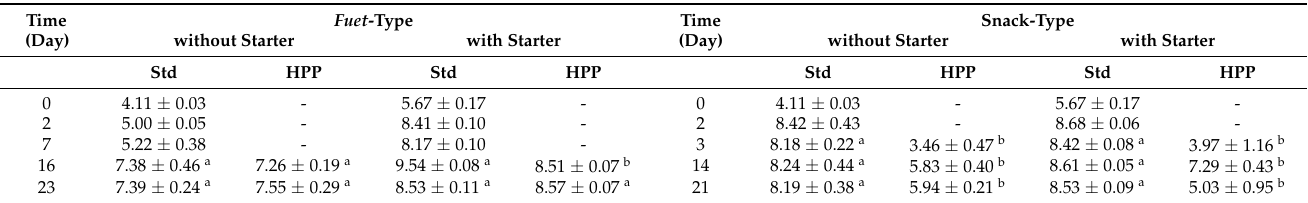
Table 2. Counts (Log 10 cfu/g) of lactic acid bacteria during the production and after storage of fuet -type (FT) and snack-type (ST) DFS. High-Pressure Processing (HPP) was applied at day 16 and 23 in FT; and at day 3, 14 and 21 in ST. Std: Standard production process. Results are expressed as mean ± standard deviation of three